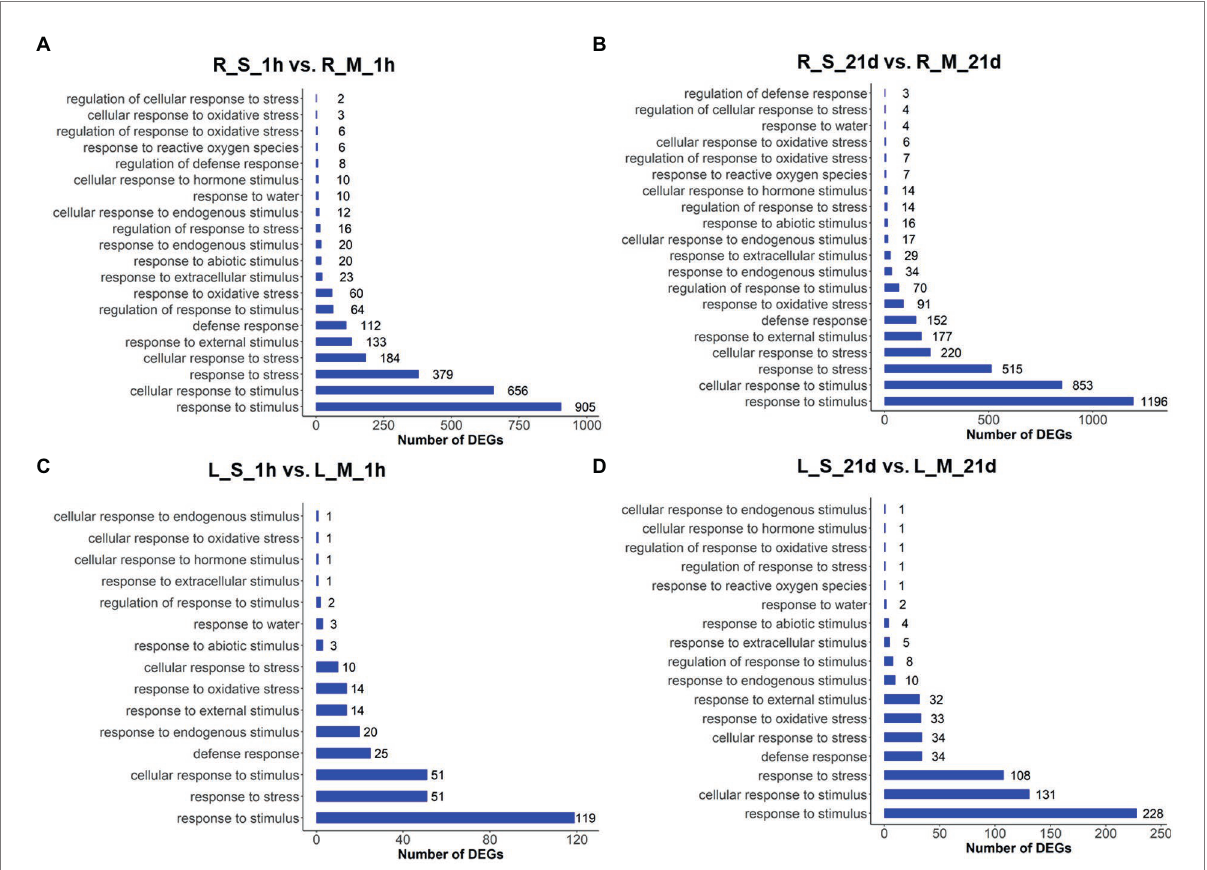
FIGURE 3 GO analysis of DEGs in roots and leaves of plants treated and untreated with 400 mM Na. The GO terms were identified based on DEGs of different comparisons: R_S_1h vs. R_M_1h (A) ; R_S_21d vs. R_M_21d (B) ; L_S_1h vs. L_M_1h (C) ; L_S_21d vs. L_M_21d (D) . The bars represent the number of DEGs in each GO